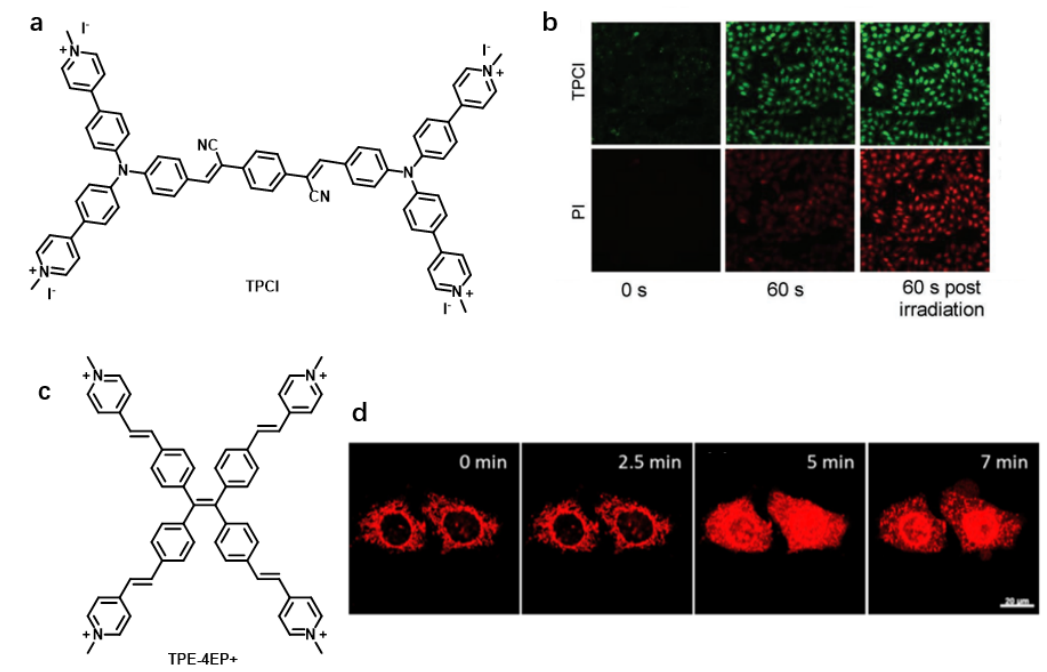
Figure 25. ( a ) The structure of TPCI. ( b ) Fluorescence microscopic images of TPCI-pretreated HeLa cells co-stained with propidium iodide (PI) at different irradiation times and post irradiation. (460 nm, 18 mW/cm 2 ), TPCI channel: (λ ex = 460–490 nm), PI channel: (λ ex = 510–550 nm). ( c ) The structure of TPE-4EP+. ( d ) Real-time confocal imaging of HeLa Cells under continuous 405 laser irradiation stained with TPE-4EP+. Reproduced from [82] and [83] with permission from John Wiley and Sons, Copyright 2019 and the American Chemical Society, Copyright 2019 respectively.